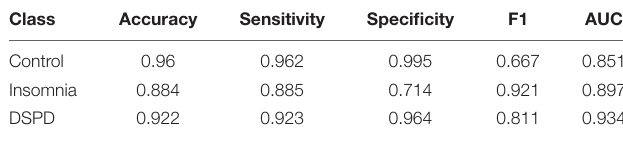
TABLE 3 | Indexes for model